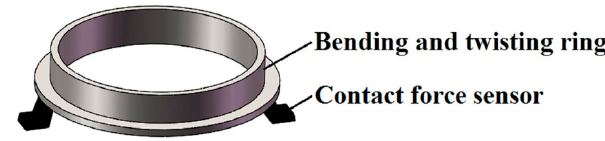
Figure 3. Bending and twisting ring.